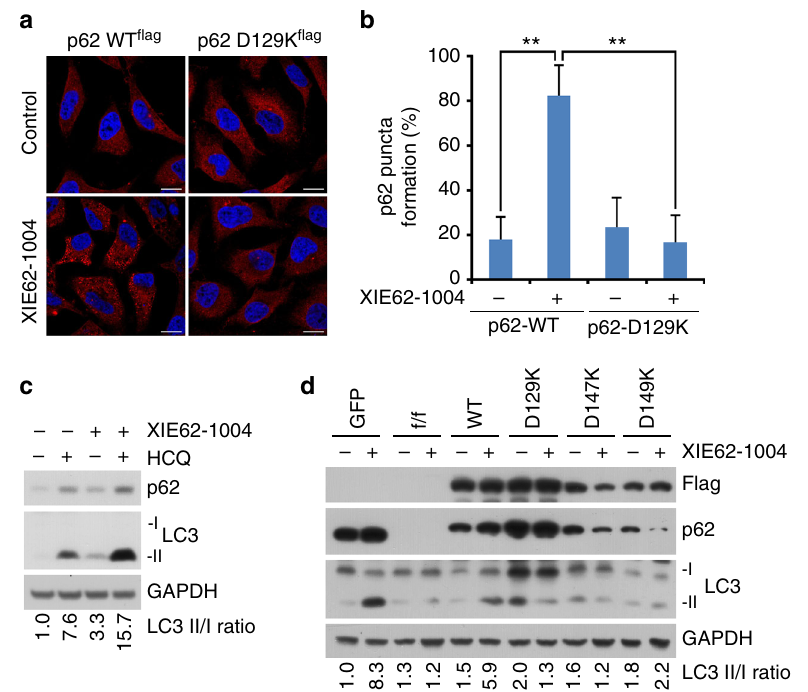
Fig. 3 p62zz mediates stress-induced autophagy. a Mouse embryonic fi broblasts expressing recombinant wild-type or D129K point mutant p62- fl ag were treated with XIE62-1004 (5 µ M, 6 h) or DMSO negative control, followed by immunostaining analysis. Scale bar, 10 µ m. b Quanti fi cation of a ( p calculated by two-tailed Student ’ s t -test; data shown as mean ± S.D. of three independent experiments each with n = 30 cells; ** p < 0.01). c Immunoblotting assay of endogenous p62-expressing mouse embryonic fi broblasts treated with XIE62-1004 (5 µ M, 6 h) in the presence or absence of hydroxychloroquine (10 µ M, 24 h) for autophagic fl ux assay. d Western blot analysis of mouse p62 fl / fl embryonic fi broblasts infected with GFP or CRE adenoviruses were reconstituted with retroviruses expressing WT Flag-p62 or point mutants of Flag-p62 treated with/without XIE62-1004 (5 µ M, 6 h). Ratio between LC3-II and LC3-I quanti fi ed by densitometry using